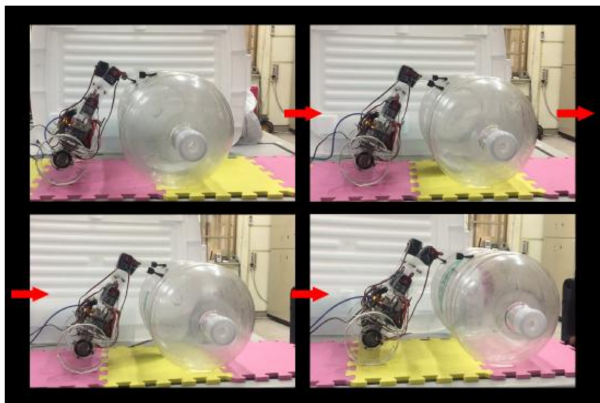
Figure 6. The motion sequence of the first version dung beetle robot rolling a